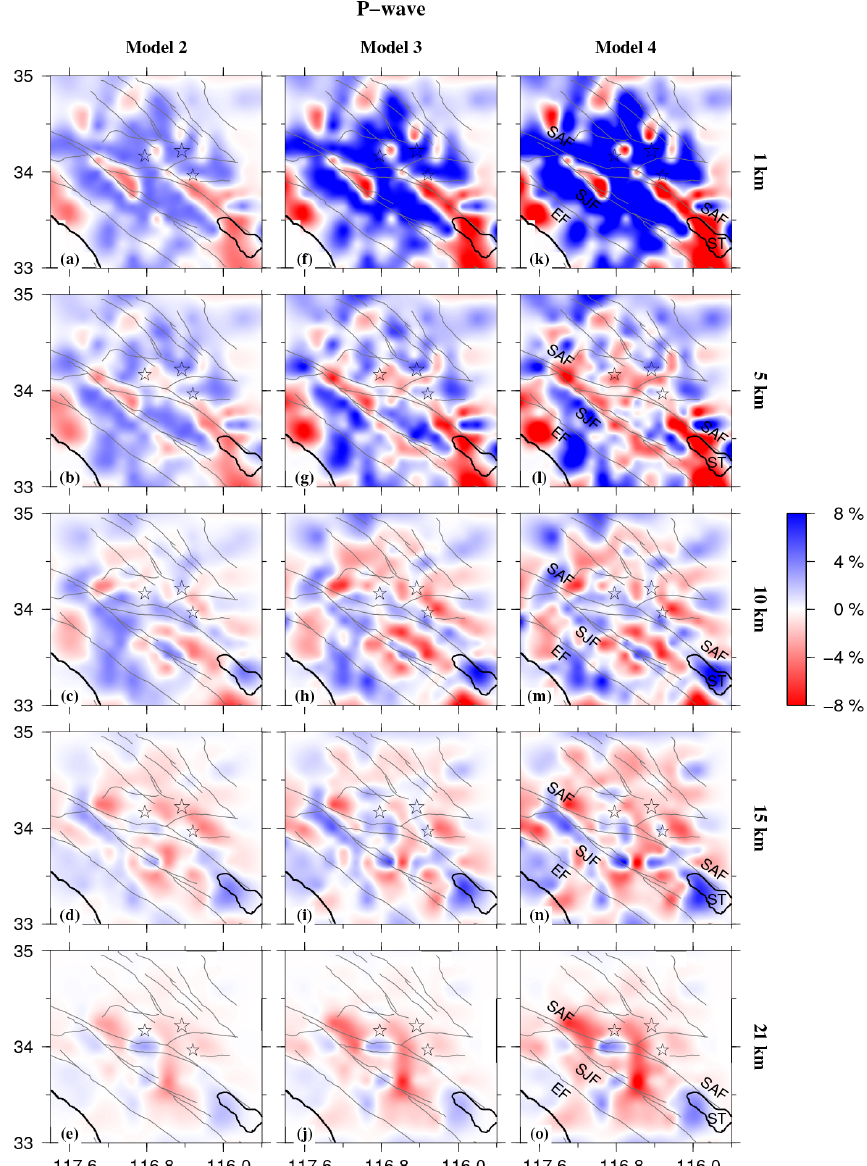
Figure 12. Map views of the P wave tomography at five representative depths for models m 2 (left column), m 3 (middle column), and m 4 (right column). The layer depth is shown just on the right hand side of each row. Red and blue colors denote low and high velocities, respectively. The velocity perturbation scale (in percent) is also shown. On each map, grey lines denote active faults, and the empty stars indicate the epicentral locations of the Landers earthquake, the Big Bear earthquake, and the Joshua Tree earthquake (Fig. 1). SAF is the short form for the San Andreas fault, SJF is the San Jacinto fault, EF is the Elsinore fault, and ST is the Salton